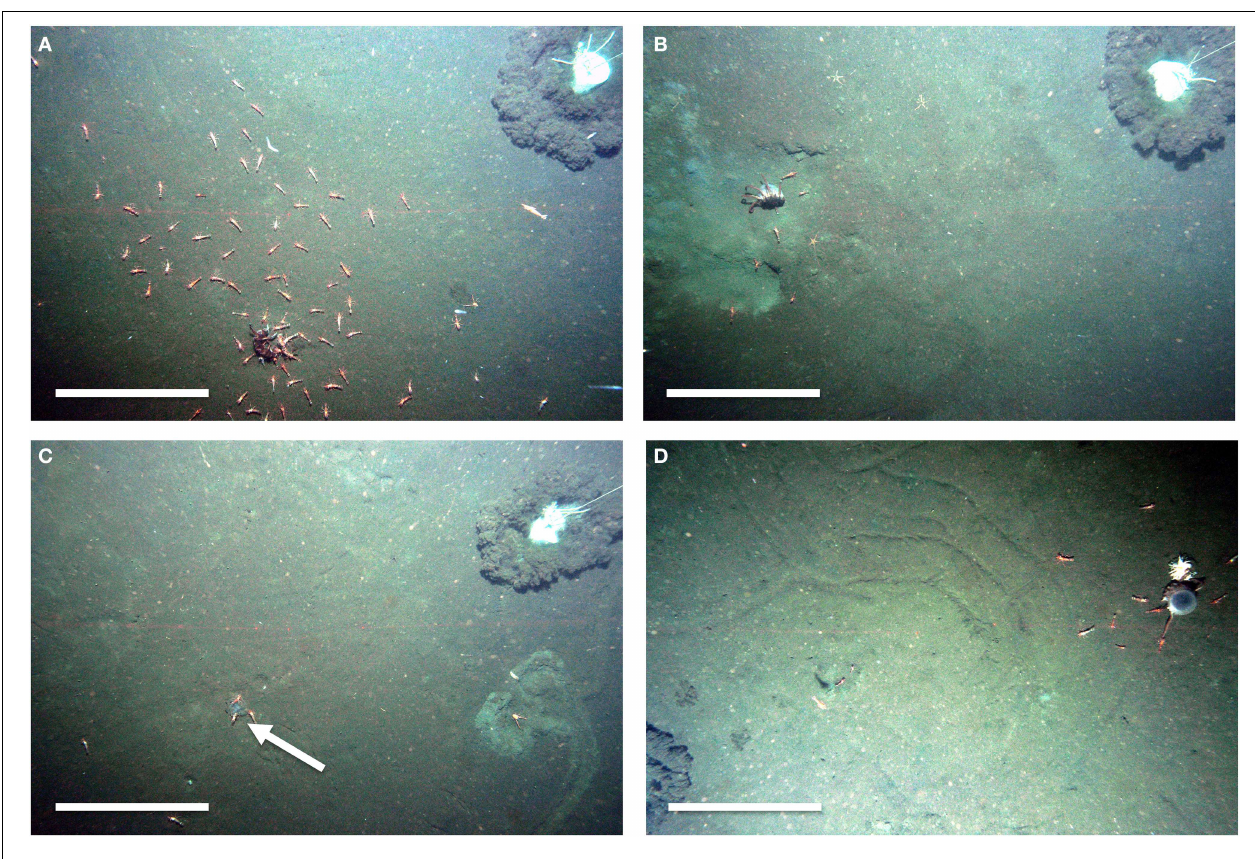
(Photograph D ). White arrow designates a small jellyfish carcass. The white scale bar is 50cm in length. Jelly-fall photographs from the deep-basin captured in March 2011 can be found in Sweetman and Chapman (2011).